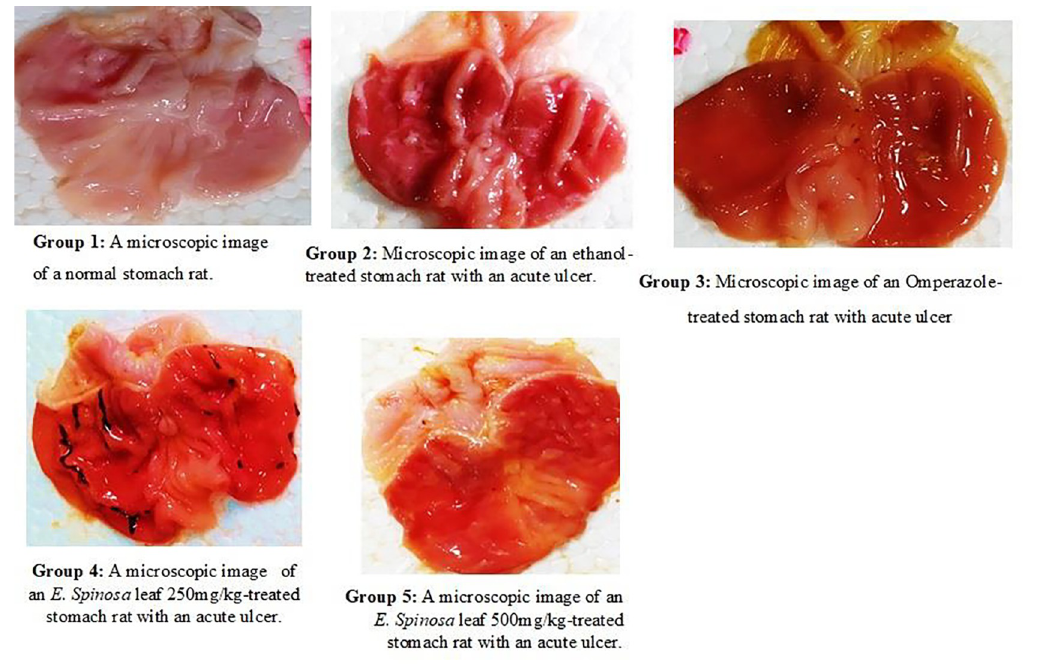
Fig 3. Microscopic evaluation of acute ethanolic-induced gastric ulcer group 1–5 represents the numbers of lesions, red spots, and hemorrhagic streaks.